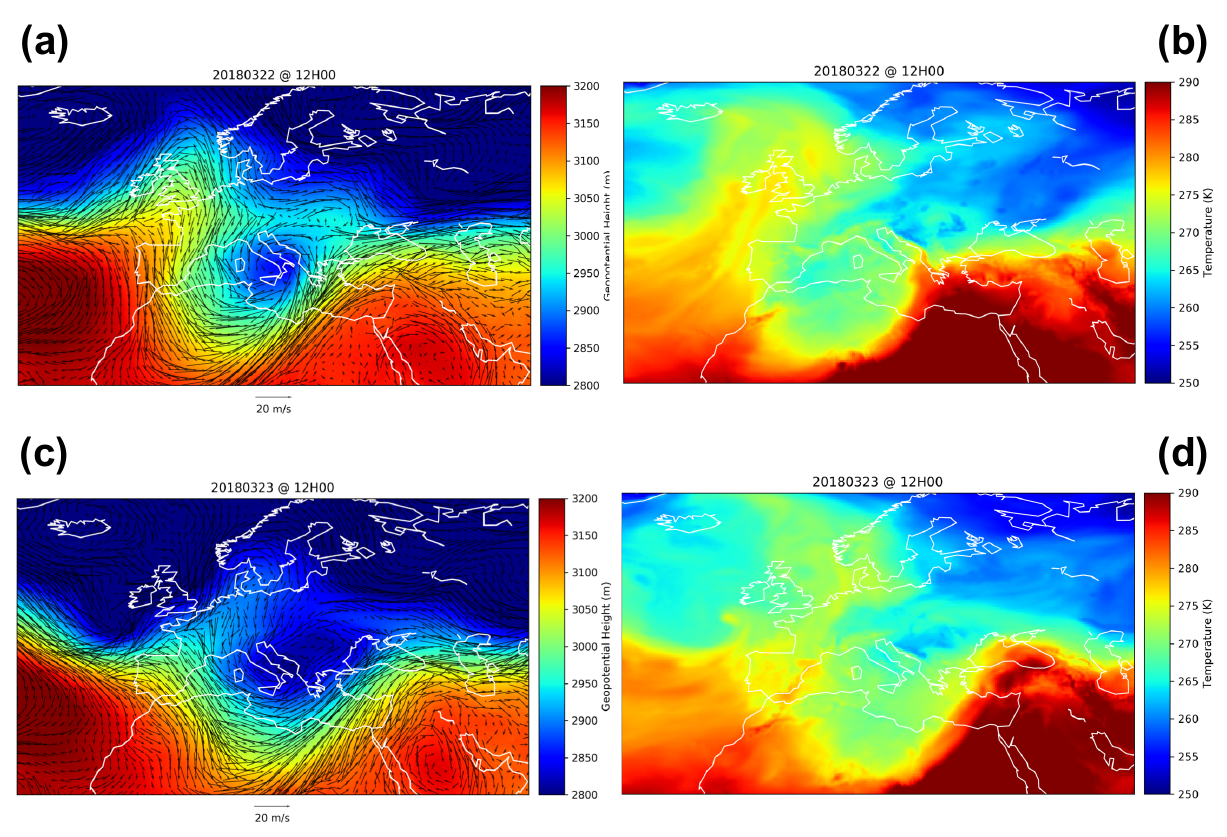
Figure 5. ( a ): Geopotential height (in m) and wind flow (in m · s − 1 ), ( b ): Temperature (in K) both on 22 March 2018 at 12:00 at the 700 hPa pressure level. ( c , d ) are the same as ( a , b ), respectively, but for the day 23 March 2018 at